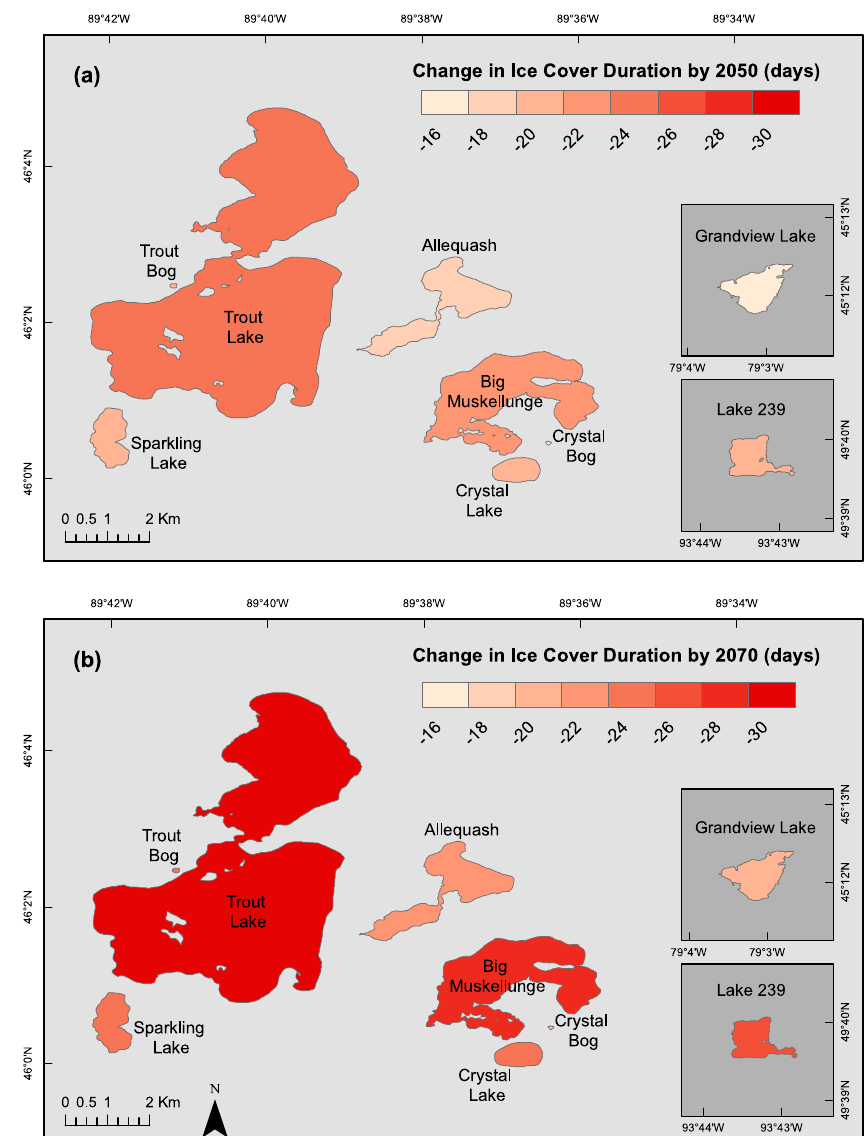
Figure 3. Projected mean loss of ice duration in nine north temperate study lakes by the year ( a ) 2050 and ( b ) 2070. The seven northern Wisconsin lakes are featured in the main map layout; Grandview Lake and Lake 239 in Ontario are featured in the darker insets.